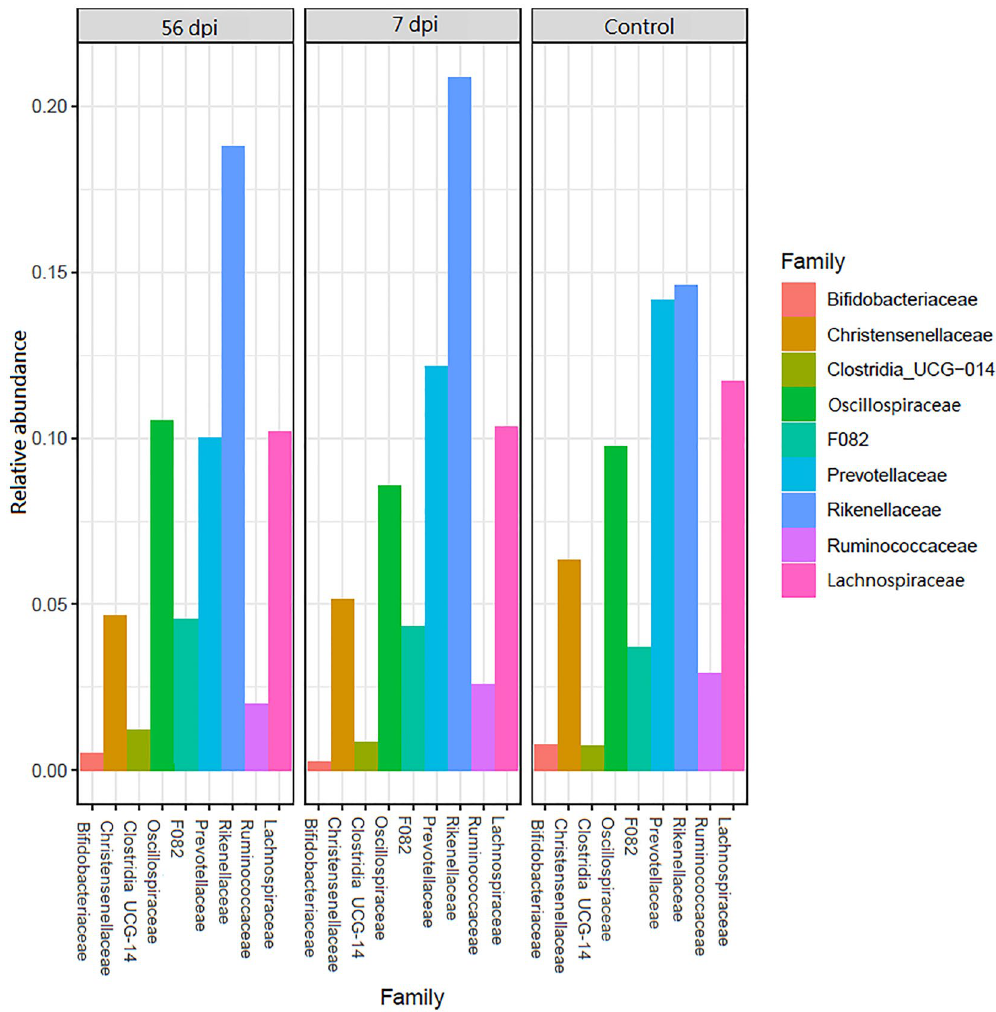
Figure 5. Abomasal composition of the most abundant microbial families of Creole goat kids comparing time points after infection with 10,000 H. contortus infective larvae (L3). 56 dpi (56 days post-infection), 7 dpi (7 days post-infection) and Control